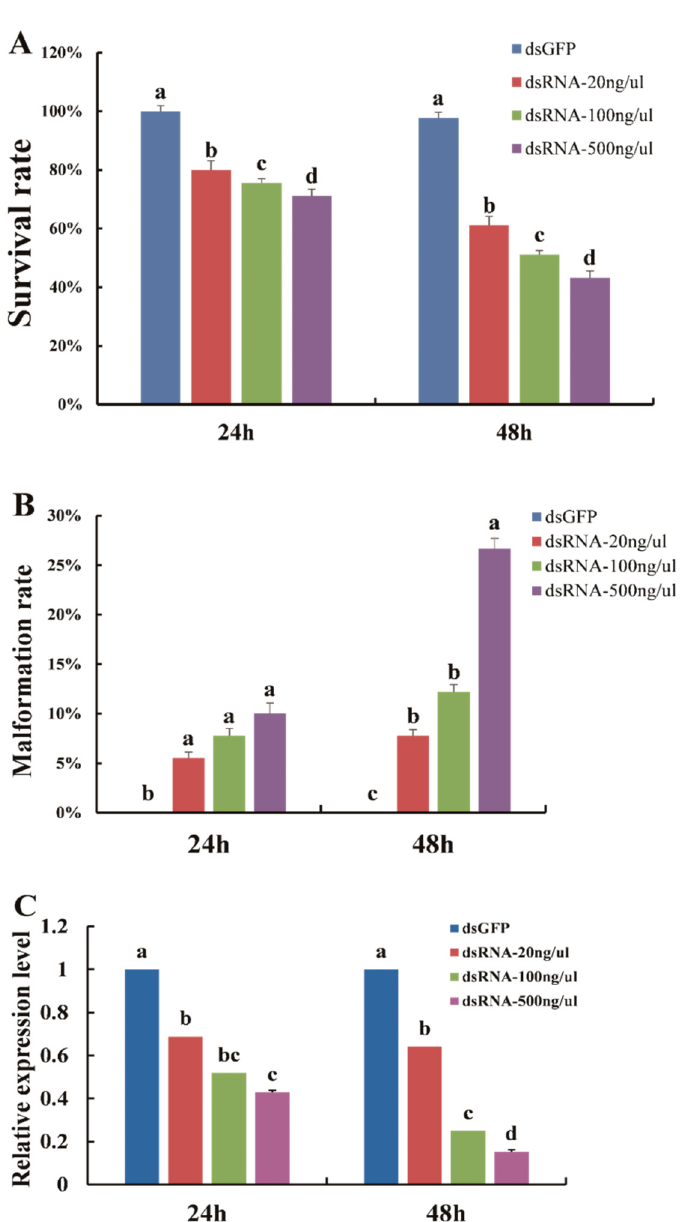
Figure 6. E ff ects of feeding ds DcTPS on survival rate ( A ), malformation rate ( B ) and relative expression levels ( C ) in D. citri . Results of control (ds GFP ) and treatment groups (ds DcTPS of 20, 100 and 500 ng / µ L) 24 and 48 h post RNAi are shown. Statistical analysis was conducted using SPSS 26.0 software. Bars with di ff erent letters are significantly di ff erent in terms of SNK test ( p < 0.05).